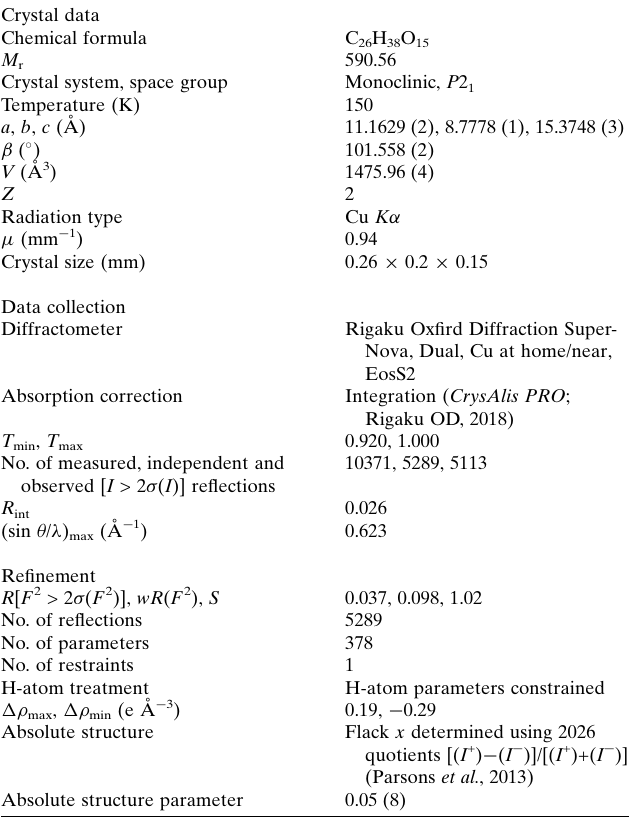
Table 2 Experimental details. Crystal data Chemical